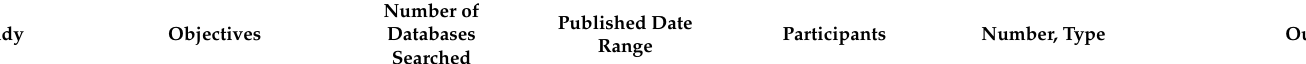
Table 1. Characteristics of included studies in the umbrella review across primary medical